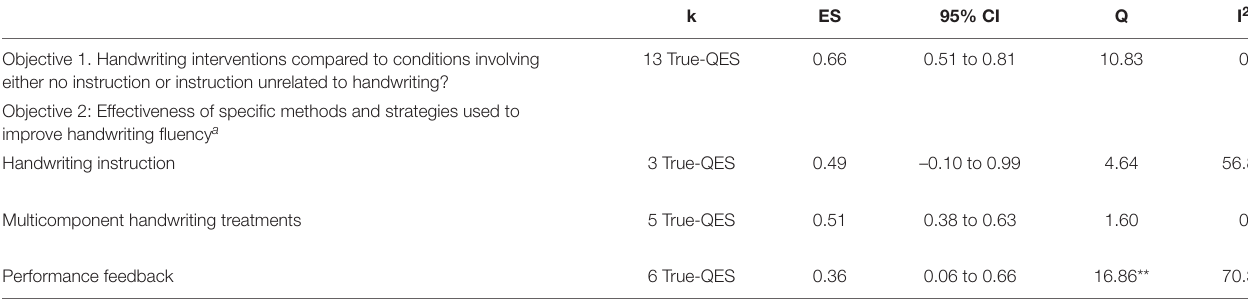
TABLE 5 | Summary of results for each research question.